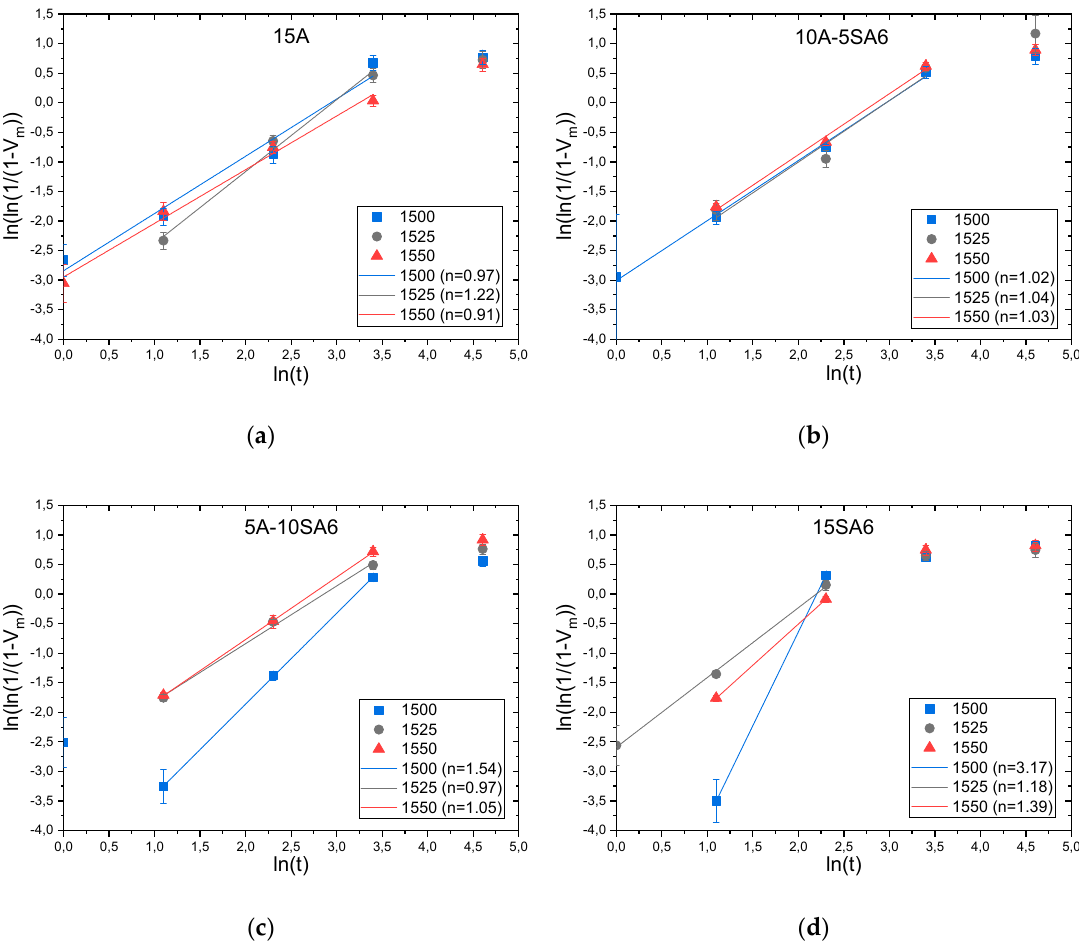
Figure 7. Mehl-Avrami-Johnson-Plots for: ( a ) 15A; ( b ) 10A-5SA6; ( c ) 5A-10SA6; ( d ) 0A-15SA6 composites.